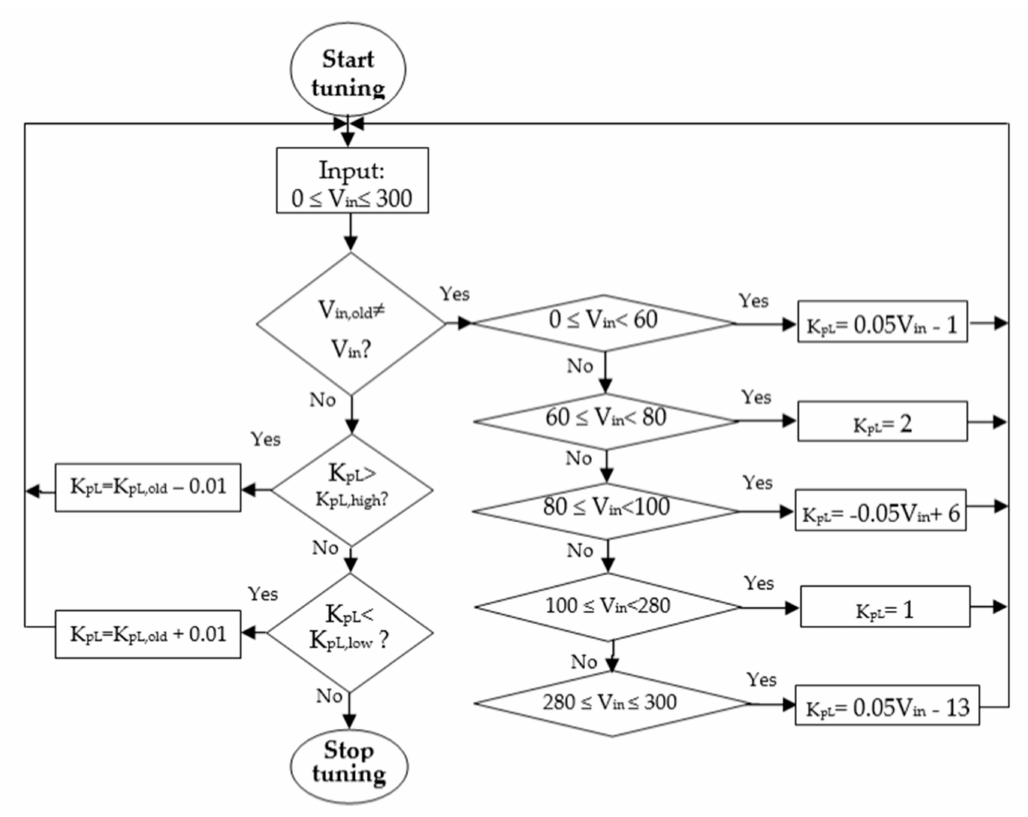
Figure 7. Online tuning mechanism for the lower part of buck-boost